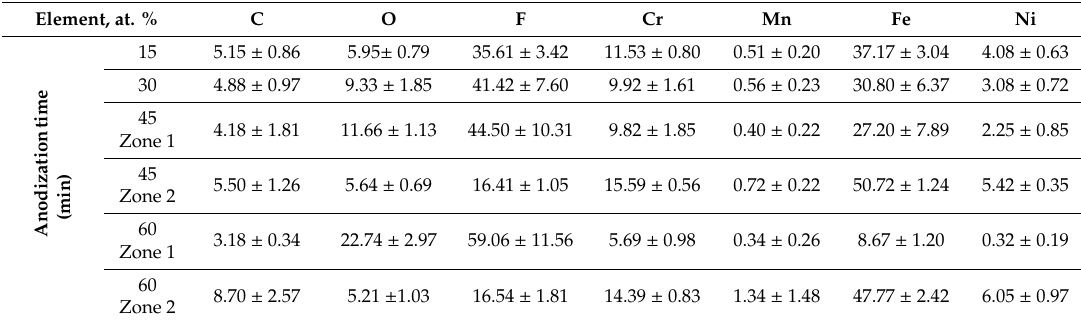
Table 1. Energy Dispersive X-ray Spectroscopy (EDX) results for the anodic layers grown at different anodizing times at 0 rpm.